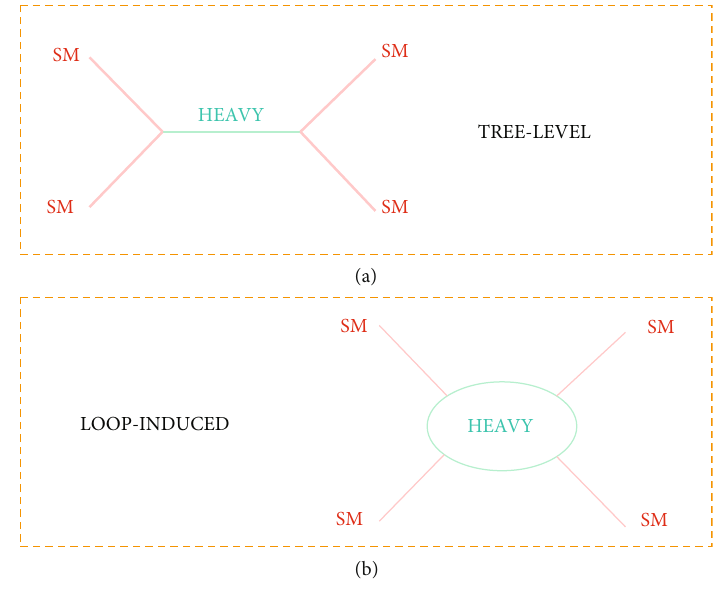
Figure 3: Sketch of the UV origin of EFT e ff